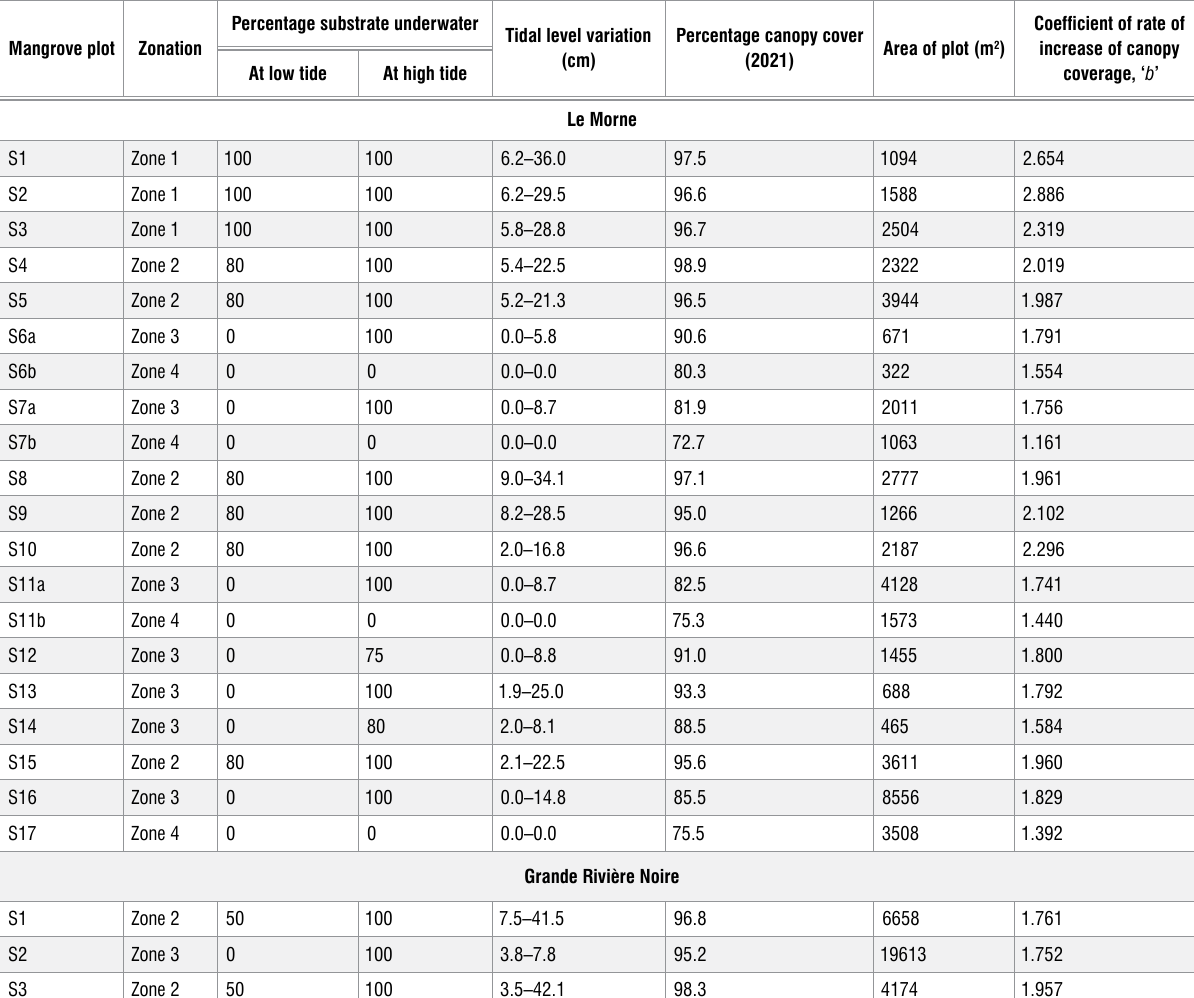
Zonation, percentage substrate underwater at low and high tides, percentage of canopy cover as of 2021, area of mangrove plot and the coefficient of rate of increase of canopy coverage, ‘b’ at Le Morne (S1–S17) and Grande Rivière Noire (S1–S3) Percentage substrate underwater Coefficient of rate of Tidal level variation Percentage canopy cover Mangrove plot Zonation Area of plot (m 2 ) increase of (cm) (2021)